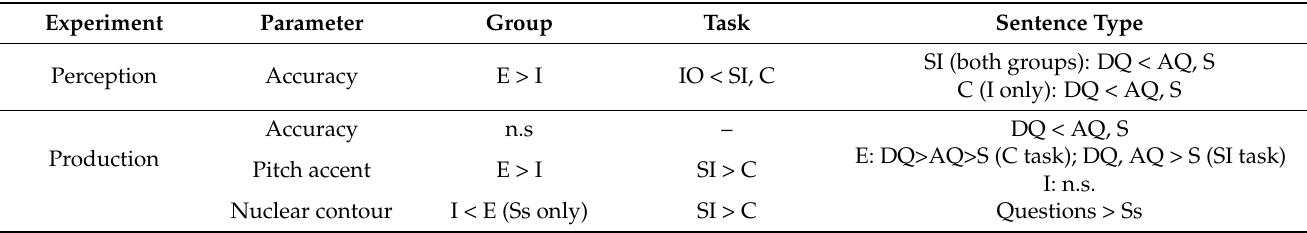
Table 11. Qualitative summary of the results obtained in the Perception and production experiments. Note: n.s. = non-significant